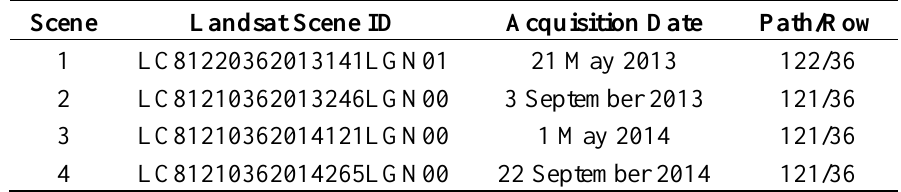
Table 1. Acquisition date and location information of four Landsat 8 images of study